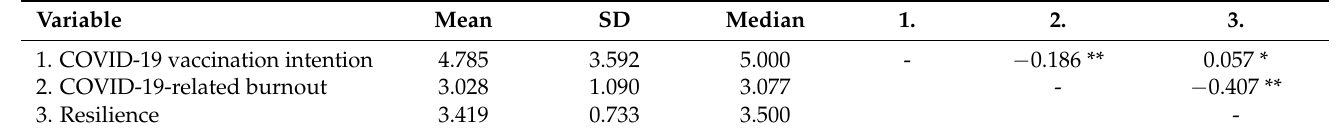
Table 2. Descriptive statistics of the study variables and correlation matrix between